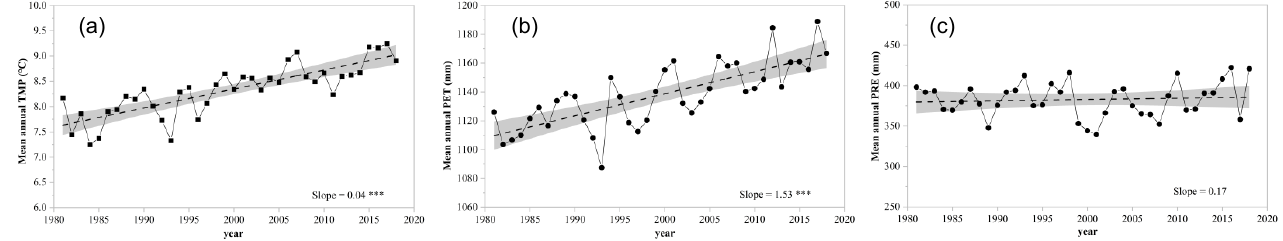
Figure 4. Temporal variations in the average annual temperature (TMP) ( a ), potential evapotranspira- tion (PET) ( b ), and precipitation (PRE) ( c ) over the entire study area from 1981 to 2018 (*** p < 0.001).